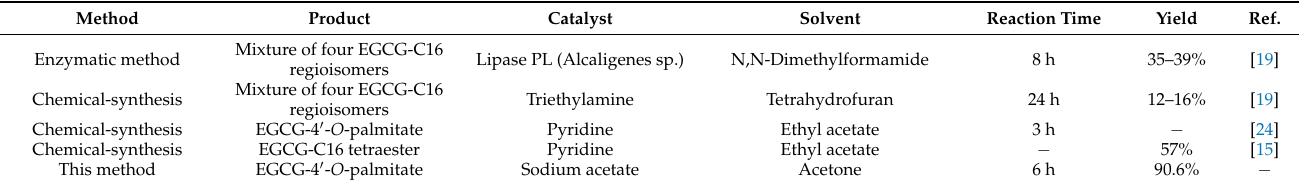
Table 1. Comparison of chemical-synthesis or enzymatic method of EGCG